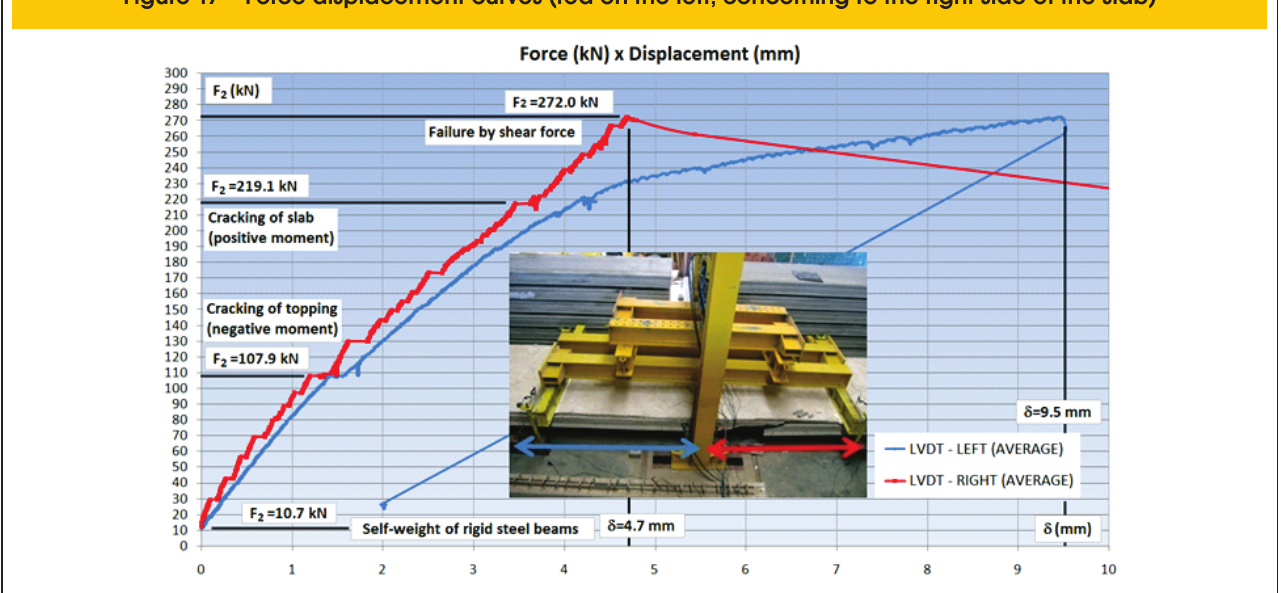
Figure 17 – Force-displacement curves (red on the left, concerning to the right side of the